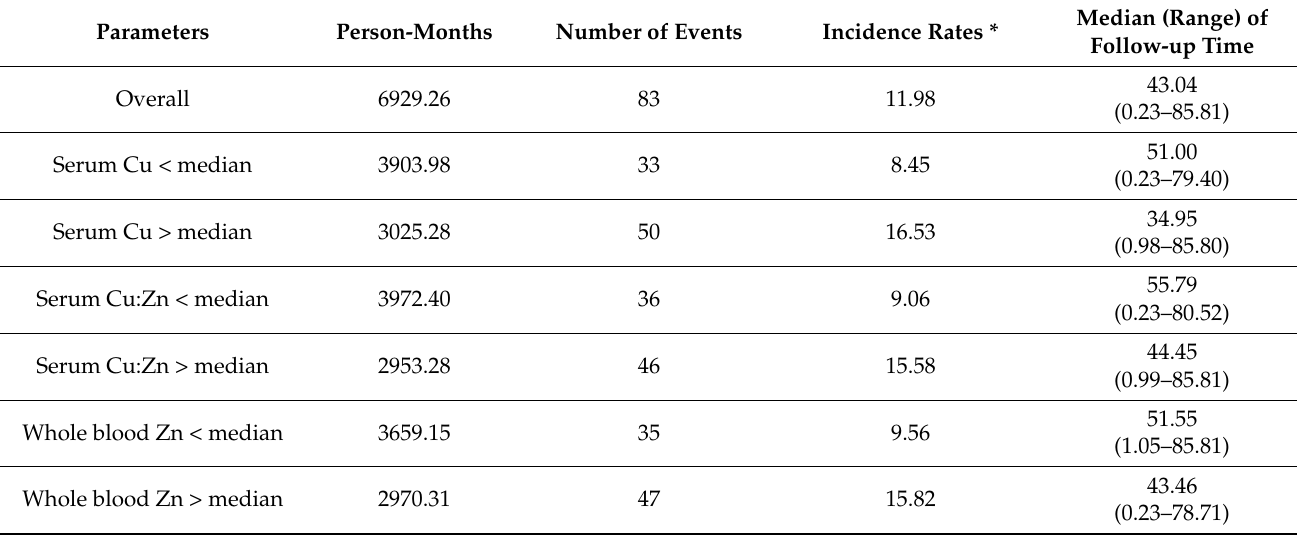
Table 5. Follow-up times and events of all-cause death in lung cancer patients by serum Cu, whole blood Zn concentrations, and serum Cu:Zn